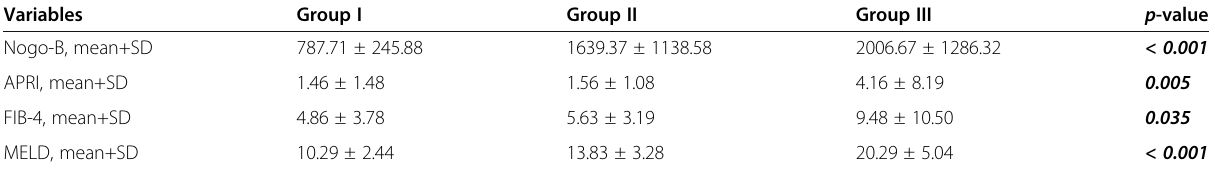
Table 2 Comparison between the three groups of patients as regards serum Nogo-B, MELD, APRI, and FIB-4 scores